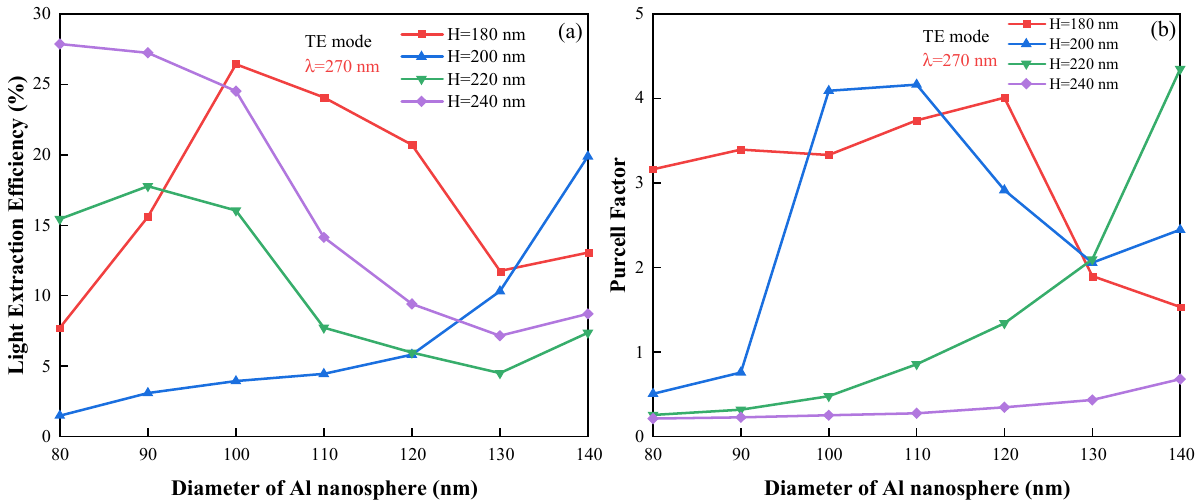
Figure 5. TE-polarized ( a ) LEE and ( b ) Purcell factor of the structure with various nanopillar heights as a function of diameter of Al nanosphere.